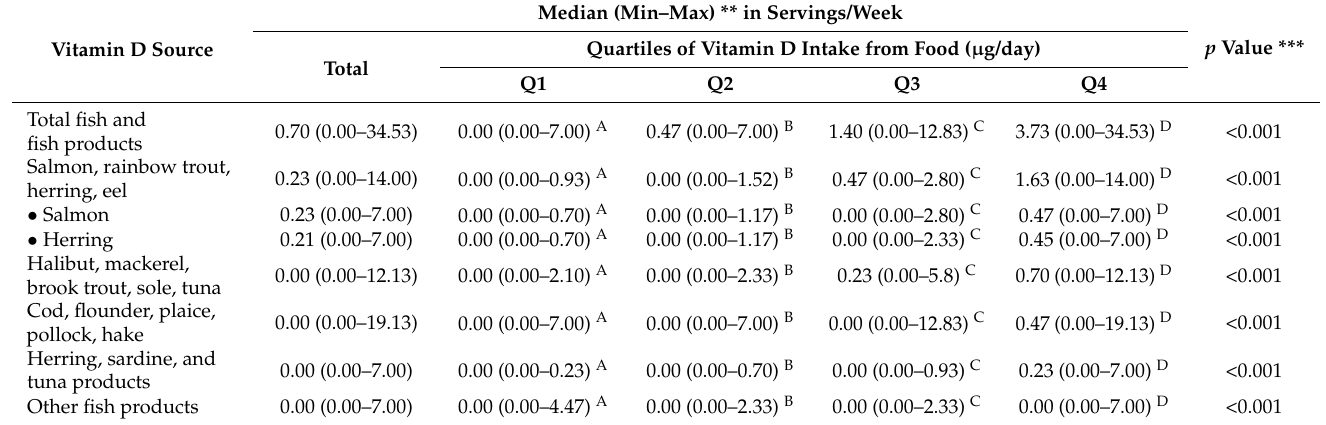
** Non-parametric distribution (verified using Shapiro-Wilk test, p ≤ 0.05), *** compared using Krus- kal-Wallis analysis of variance (ANOVA), values with different letters (A, B, C, D) in rows differ